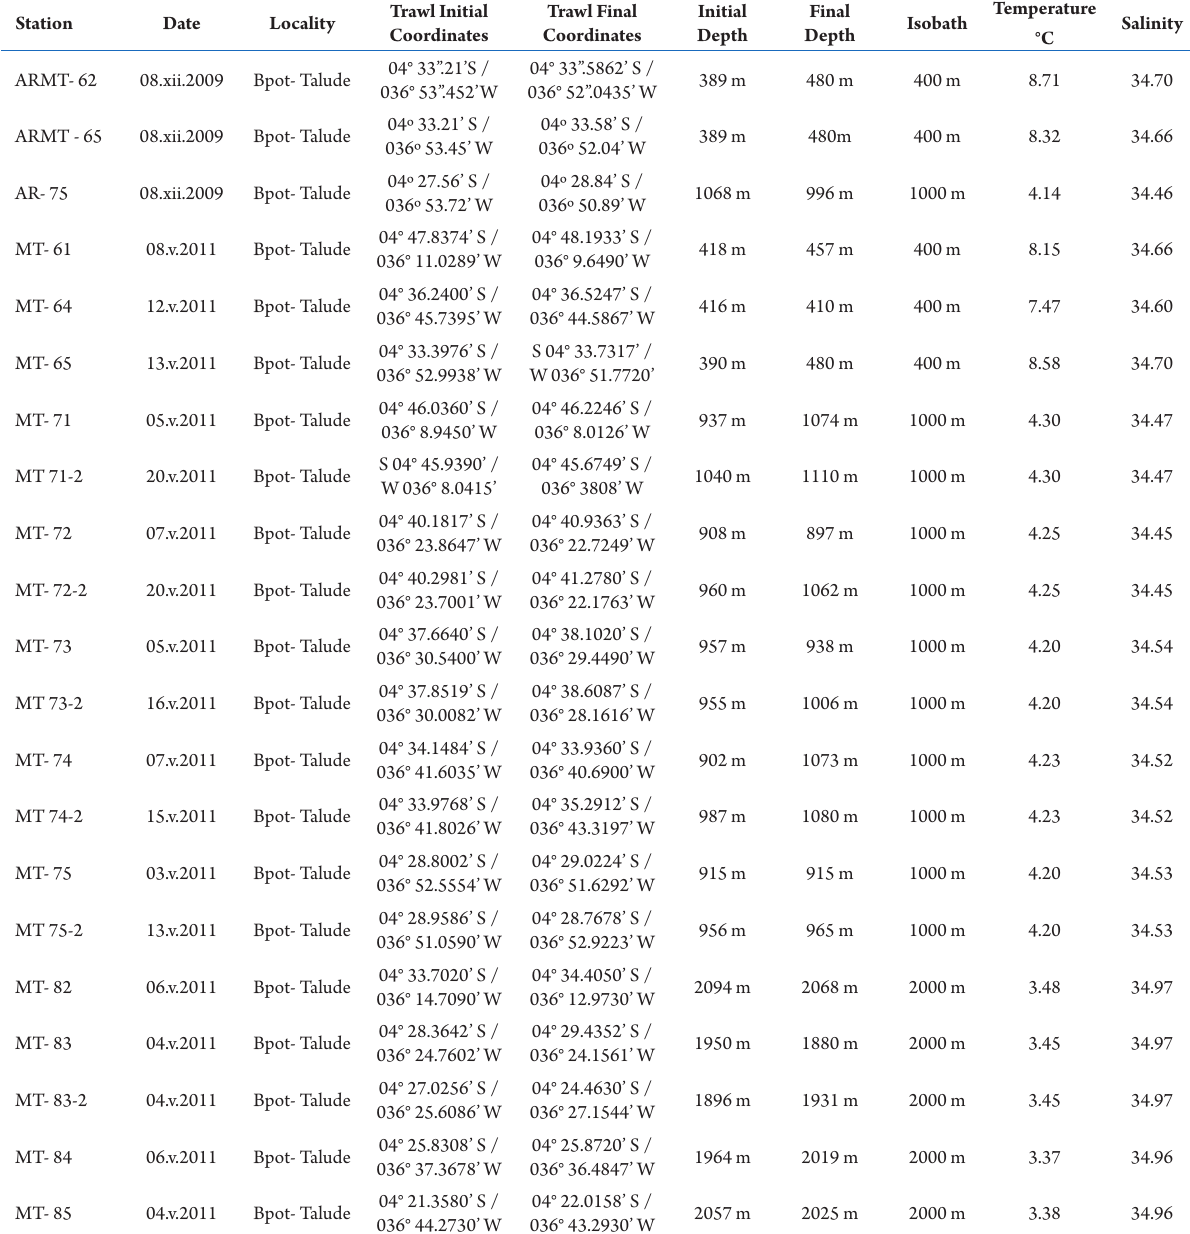
Table 1. Stations list for the species of Glyphocrangon A. Milne-Edwards, 1881 with station number, sampling date, locality, initial